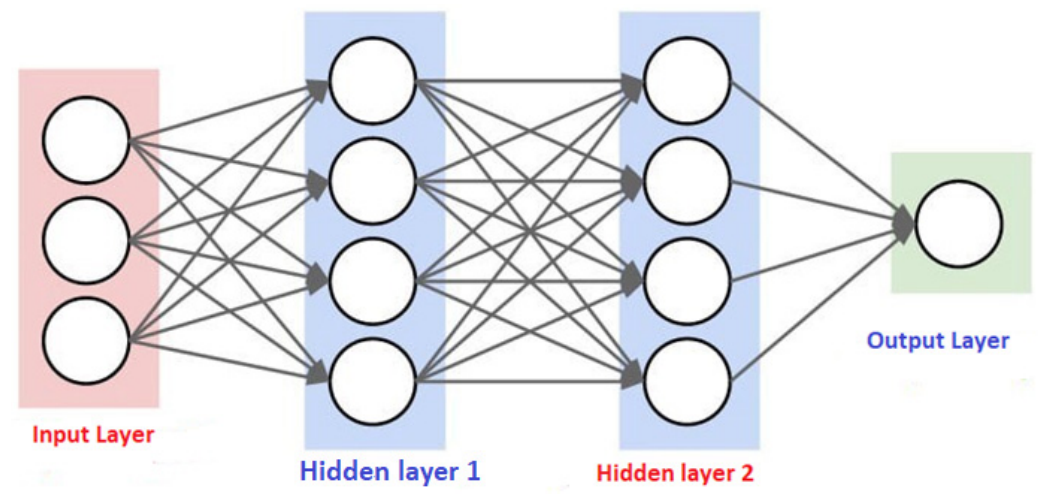
Figure 3. Diagram representing ANN.